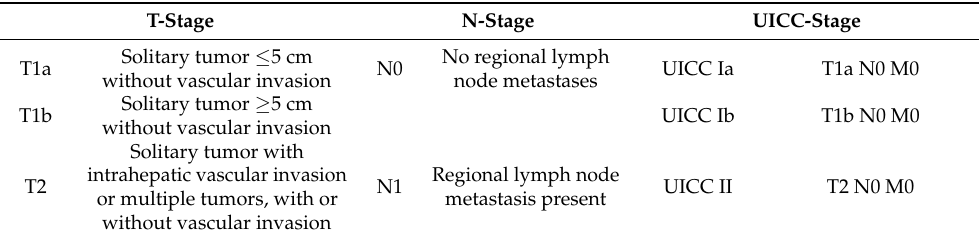
Table 1. Definitions of the 8th edition of the UICC classification.